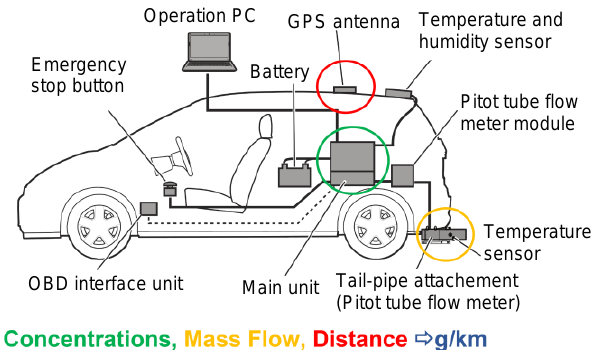
Fig. 1. Set-up of PEMS on a